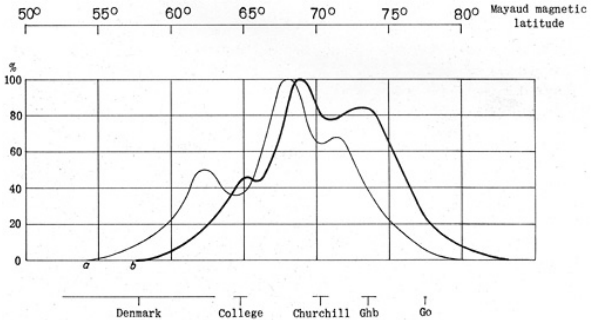
Figure 23. Latitude dependence for night auroras at sunspot maxi- mum (a) and minimum (b) (Lassen,